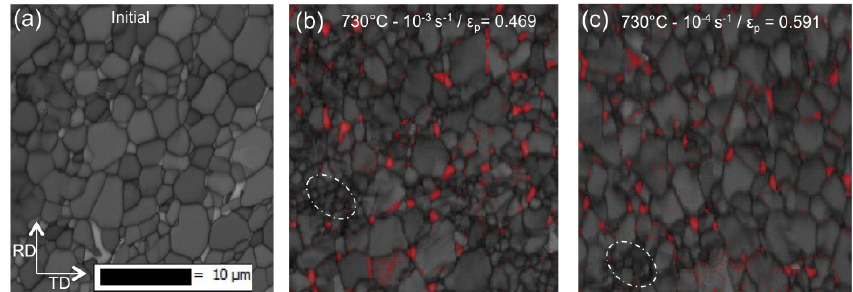
Figure 5. Image Quality maps in an equiaxed area of the Ti6242 alloy ( a ) prior to deformation and after deformation at 730 ◦ C with a plastic deformation of ( b ) 0.469 at 10 − 3 s − 1 and ( c ) 0.591 at 10 − 4 s − 1 . In ( b , c ) the red color remains to the β phase and circled areas are example of recrystallized zones.